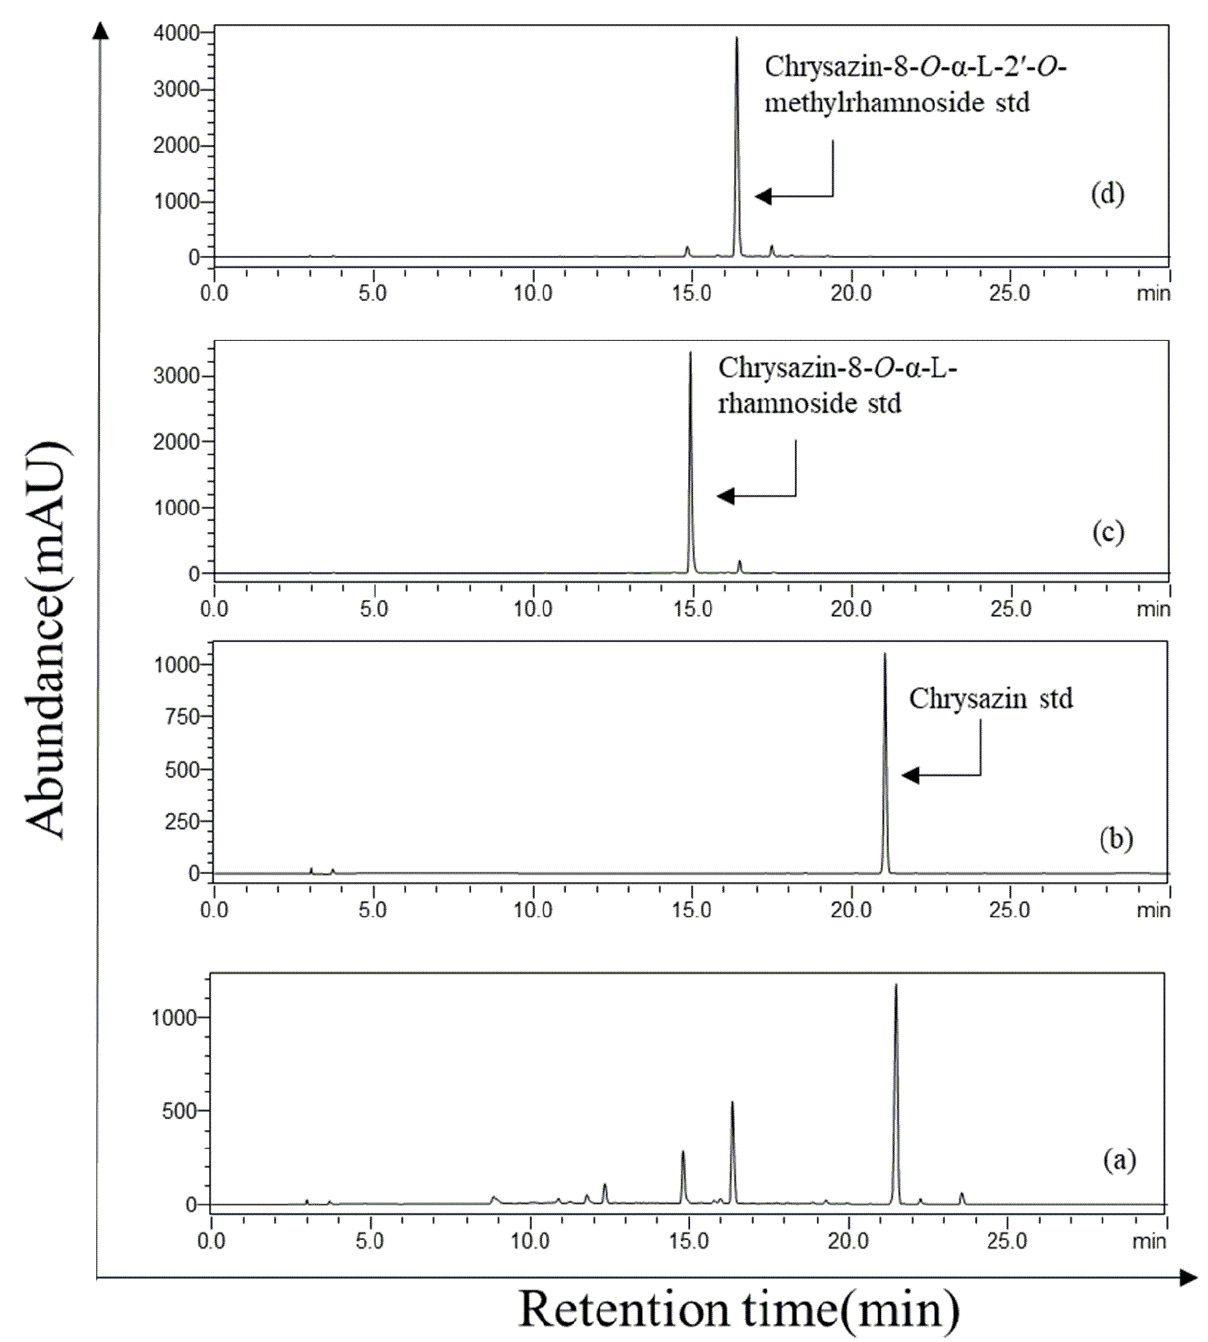
Figure 2. Whole-cell biotransformation of chrysazin to chrysazin-8- O - α - L -rhamnoside and chrysazin- 8- O - α - L -2 (cid:48) - O -methylrhamnoside using engineered E. coli S2 overexpressing anthraquinone glycosyl- transferase, sugar-MT (ThnM1), TDP-rhamnose sugar biosynthetic pathway overexpressing plasmid, and SAM synthase overexpressing plasmid. HPLC-PDA chromatogram analyses of ( a ) biotransformation reaction sample compared to ( b ) chrysazin standard, ( c ) chrysazin-8- O - α - L -rhamnoside standard, ( d ) chrysazin-8- O - α - L - 2′ - O -methylrhamnoside.